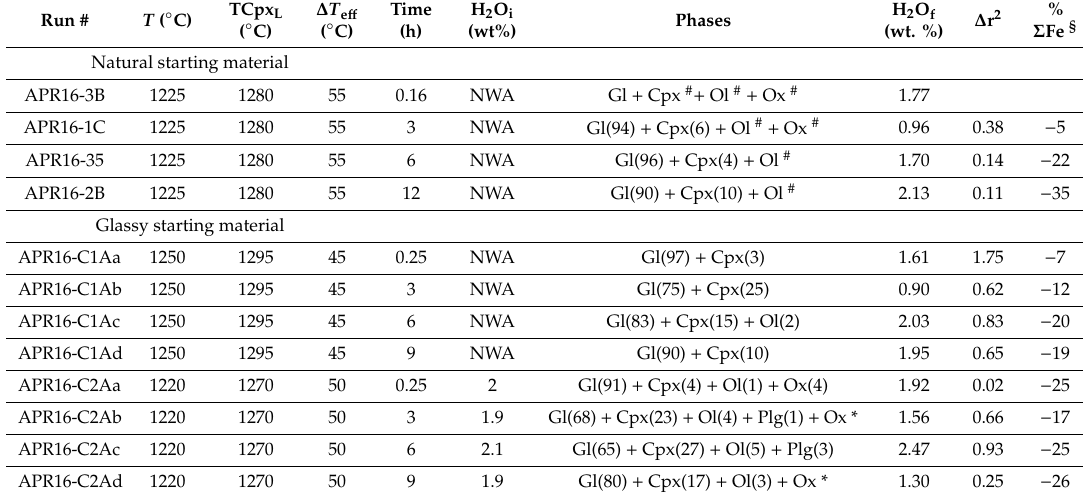
Table 2. Experimental run conditions, calculated water contents, phases assemblage and proportions in run